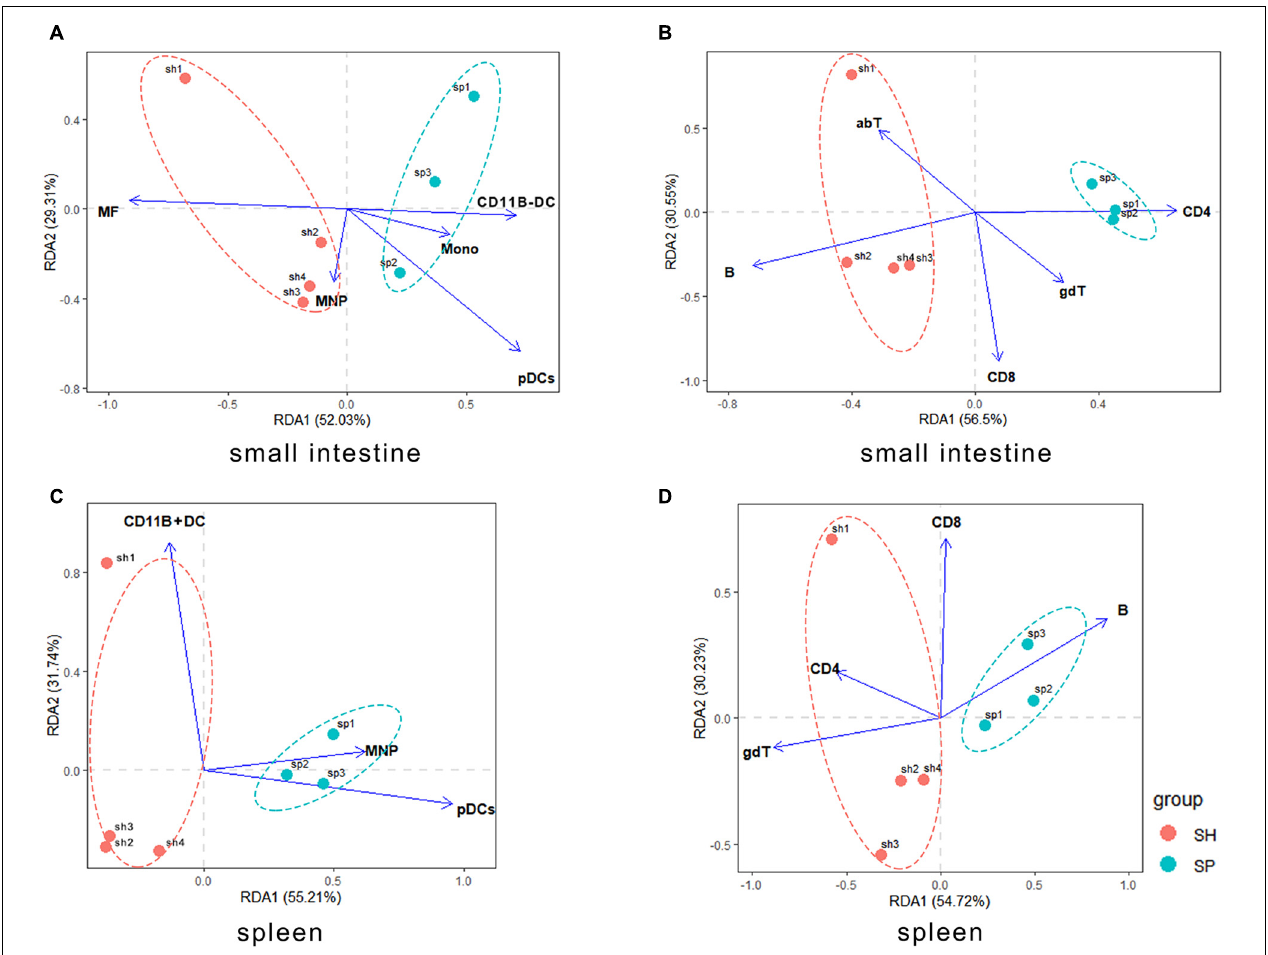
FIGURE 4 | Correlations between the local and systemic immune cells and gut bacterial community. (A,B) Gut microbiota associated with the innate and adaptive immune cells in the murine small intestine. (C,D) Gut microbiota associated with the innate and adaptive immune cells in the murine spleen. The individual mouse gut microbial community was represented by one